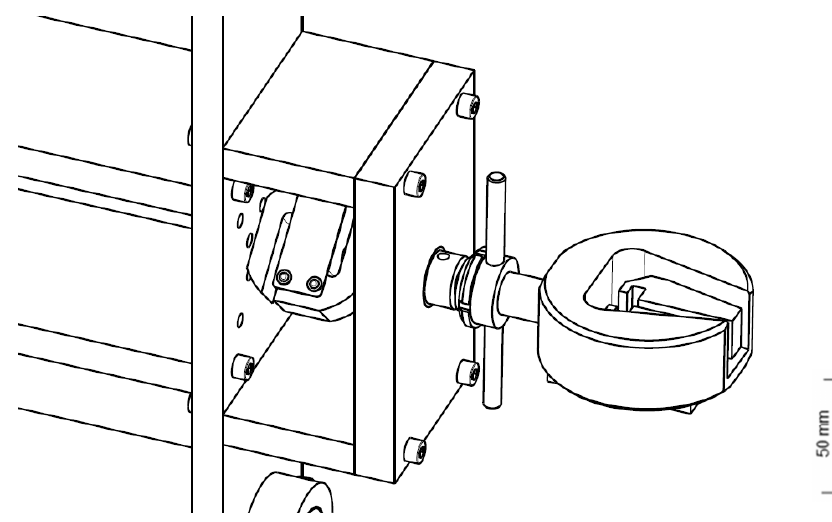
Figure 10. Illustration of the grip support.